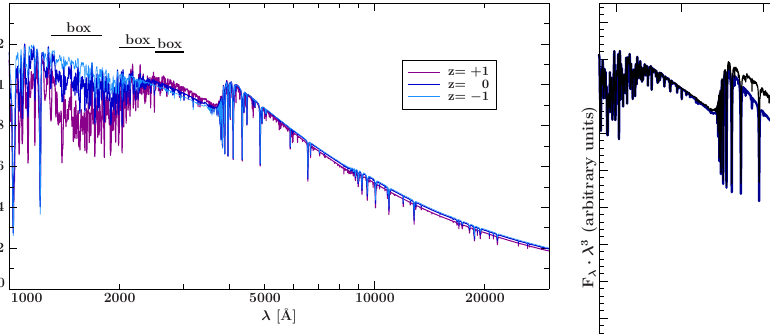
Figure 4. Model SED for different metallicities (scaled typical sdB pattern from Naslim et al. 2013). The UV box filters are marked by horizontal lines. Note that the flux depression is strongest in the shortest wavelength box filter.